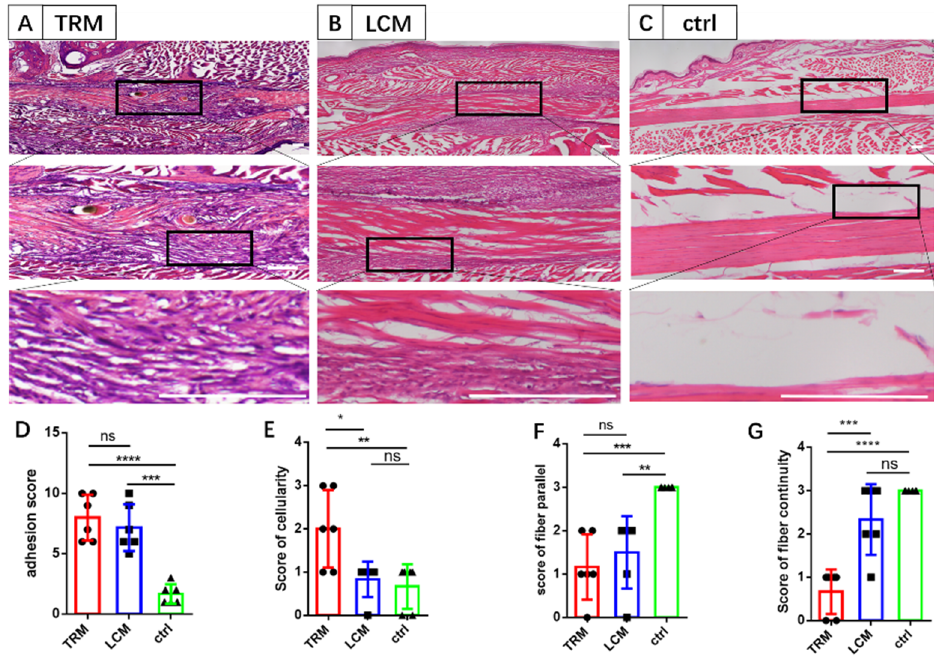
Figure 2. The evaluation of tendon adhesion and healing in the three groups. ( A – C ) The H&E staining showing space between the tendon and its surrounding tissue. ( D ) Tendon adhesion score. ( E – G ) Tendon healing scores including the cellularity score, parallel fiber score and fiber continuity score. n = 6 mice for all groups. Scale bars, 200 μ m. Mean ± SD, * p < 0.05; ** p < 0.01; *** p < 0.001; **** p < 0.0001; ns, no significance.